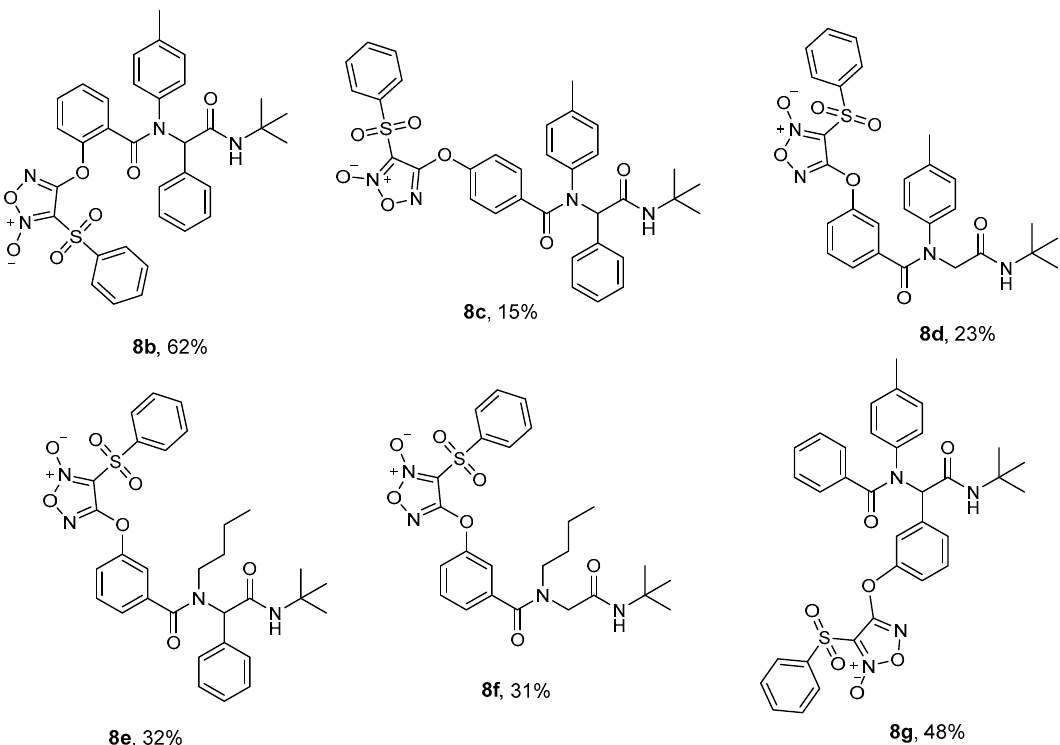
Figure 2. Scope of ·NO donors via Ugi MCR under optimized greener conditions (overall yield).